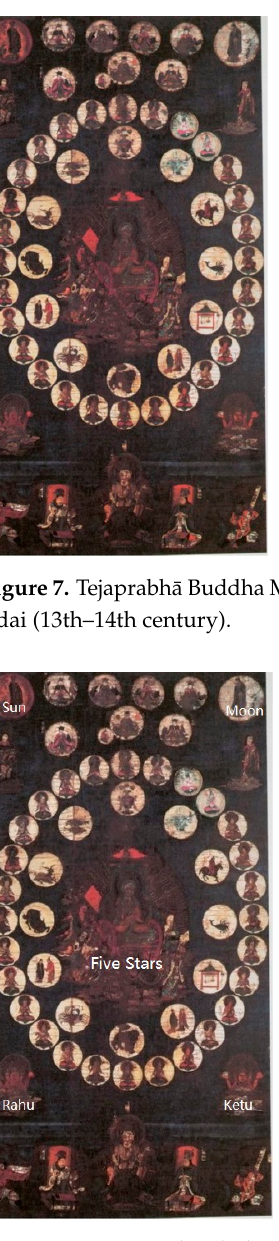
Figure 8. Iconographical identification of Figure 7.